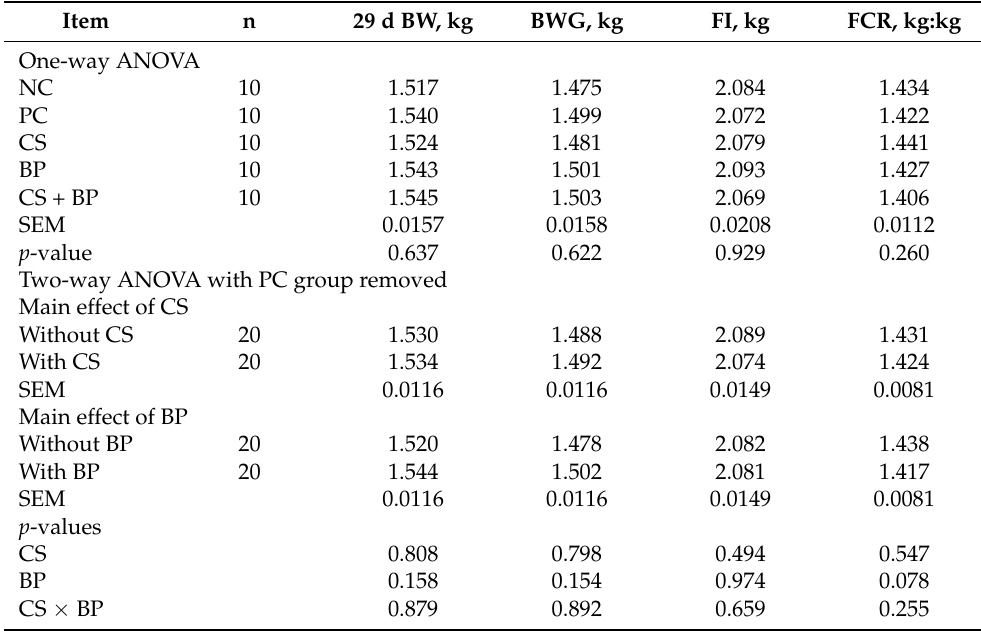
Table 3. Live performance of broilers fed diets with and without bacitracin methylene disalicylate or various antibiotic alternatives from 0 to 29 d post-hatch 1